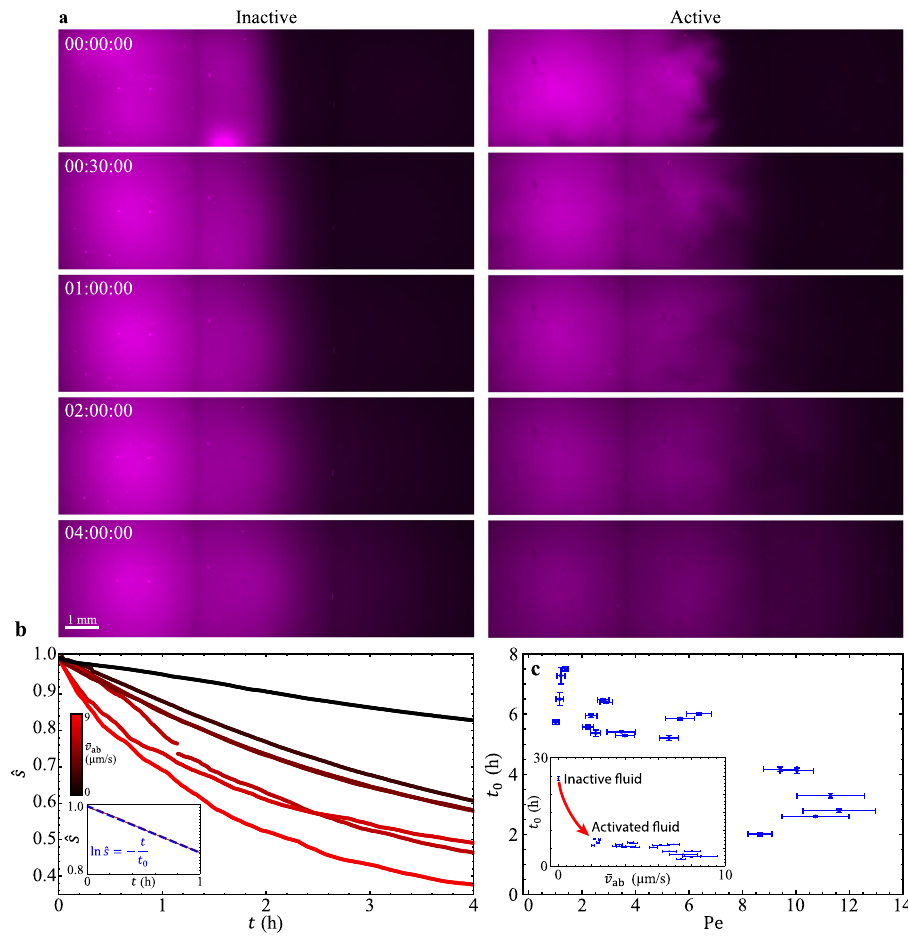
Fig. 5 | (Experimental results) Dispersion of UV-activated fl uorescent dyes in active-inactive fl uid systems. Active fl uid fl ows promote mixing of UV-activated fl uorescent dyes, which are initially activated in the left-hand side of the container only. a Dispersion of UV-activated fl uorescent dyes (magenta) in inactive ( (cid:1) v ab = 0; left column) and active ( (cid:1) v ab = 8.2 µ m/s; right column) microtubule-kinesin fl uid. Active fl uid fl ows activelytransport fl uorescent dyesand enhancetheir dispersion. Time stamps are hour:minute:second. (See also Supplementary Movie 3.) b Selec- ted examples of normalized multiscale norm vs. time for different active bulk fl ow speeds, (cid:1) v ab . Normalized multiscale norm ^ s t ð Þ decreases faster in a faster- fl owing active fl uid system. Inset: The normalized multiscale norm, ^ s t ð Þ , in log-linear axes behaves asa straight line, which suggests that the norm decays exponentially with time. The decay time scale t 0 (or mixing time) is determined by fi tting the